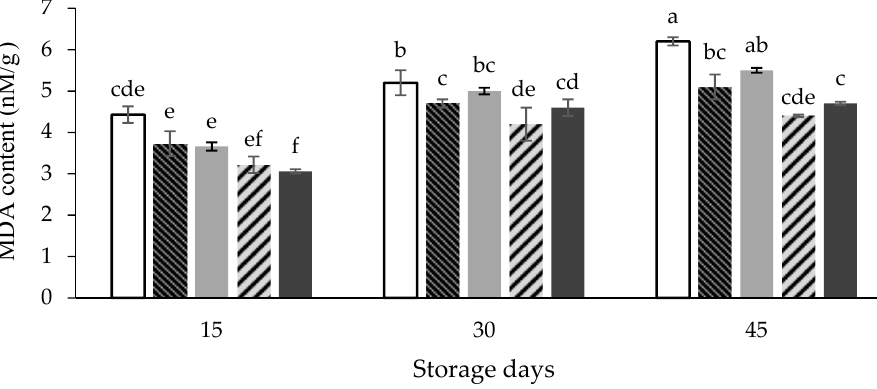
Figure 3. Effects of chitosan, phenylalanine, and chitosan-coated phenylalanine nanoparticles treatments on the MDA content of persimmon fruit during storage at 4 °C for 15, 30, and 45 days. Each value represents the mean ± standard errors of three replications. Different letters indicate statistical differences using Duncan’s multiple range tests at P < 0.05 level.